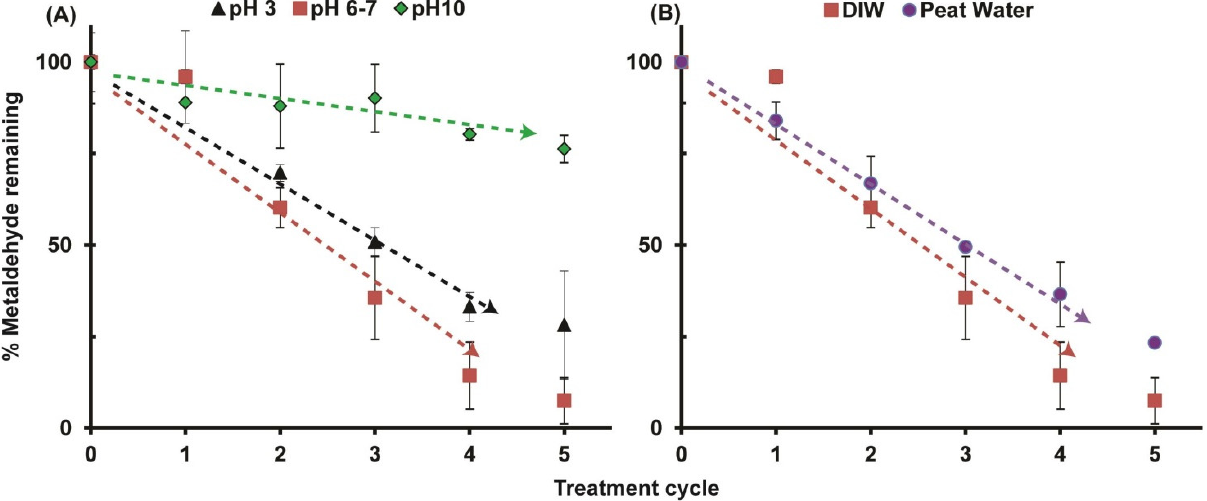
Figure 5. Metaldehyde remaining (expressed as a percentage of the mean starting concentration of 8000 µg/L) after successive treatment cycles using the coupled adsorption and electrochemical regeneration technology ( A ) for different initial pHs and ( B ) in the presence and in the absence of other organics in peat water. Dotted arrows indicate generalised trends. Bars indicate the error; when they are not visible, the error bar is smaller than the symbol used. All experiments were carried out with mixing and regeneration times of 15 min and a current of 0.5